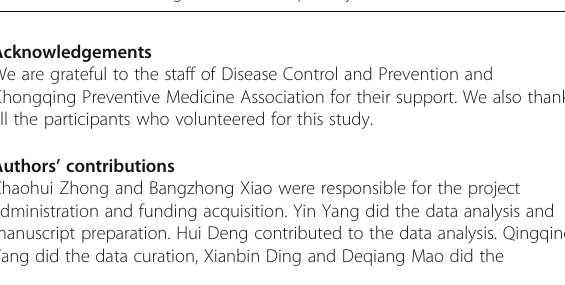
Additional file 1: Supplementary Figure 1. Flow chart for sampling subjects. Additional file 2. Original data of 14 poverty state